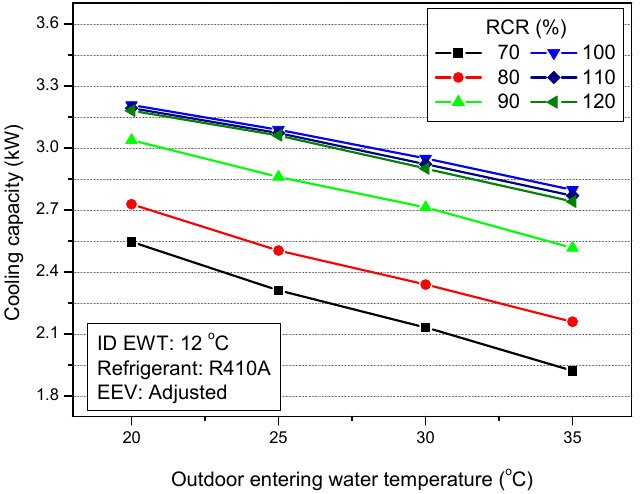
Figure 8. Variation of cooling capacity with T OD in cooling mode.